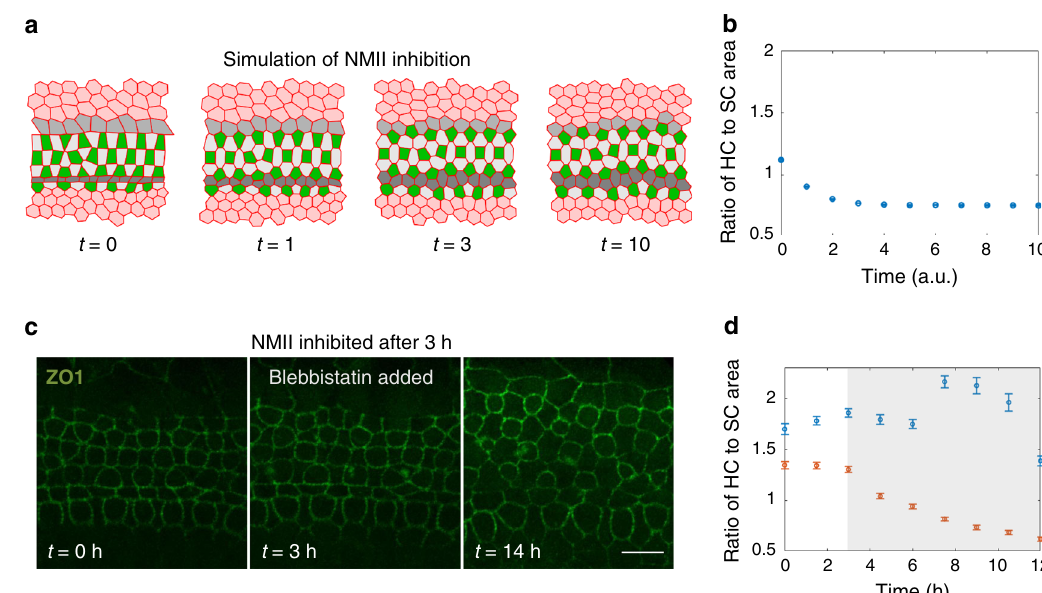
Fig. 5 Model successfully predicts morphological changes induced by NMII inhibition. a A fi lmstrip of a simulation modeling NMII inhibition. The addition of a NMII inhibitor, blebbistatin, was simulated by reducing and equating the tension for all junction types and overall contractility. Simulation starts at the end point of the simulations shown in Fig. 3. Movie shown in Supplementary Video 13. b Analysis of the ratio of HC area to SC area during the simulations. Model predicts a decrease in the ratio of HC to SC area. Data is averaged over n = 30 simulations. c A fi lmstrip from an E17.5 ZO1-EGFP explant treated with blebbistatin (10 µ M). Blebbistatin was added 3 hours after the movie started. Movie shown in Supplementary Video 14. Scale bar: 10 µ m. d Analysis of the ratio of HC area to SC area as a function of time demonstrated a decrease in the ratio of HC to SC areas in experiments where blebbistatin was added (red) compared to control experiments with no addition of blebbistatin (blue). Data is averaged over n = 3 experiments. Error bars in b , d indicate